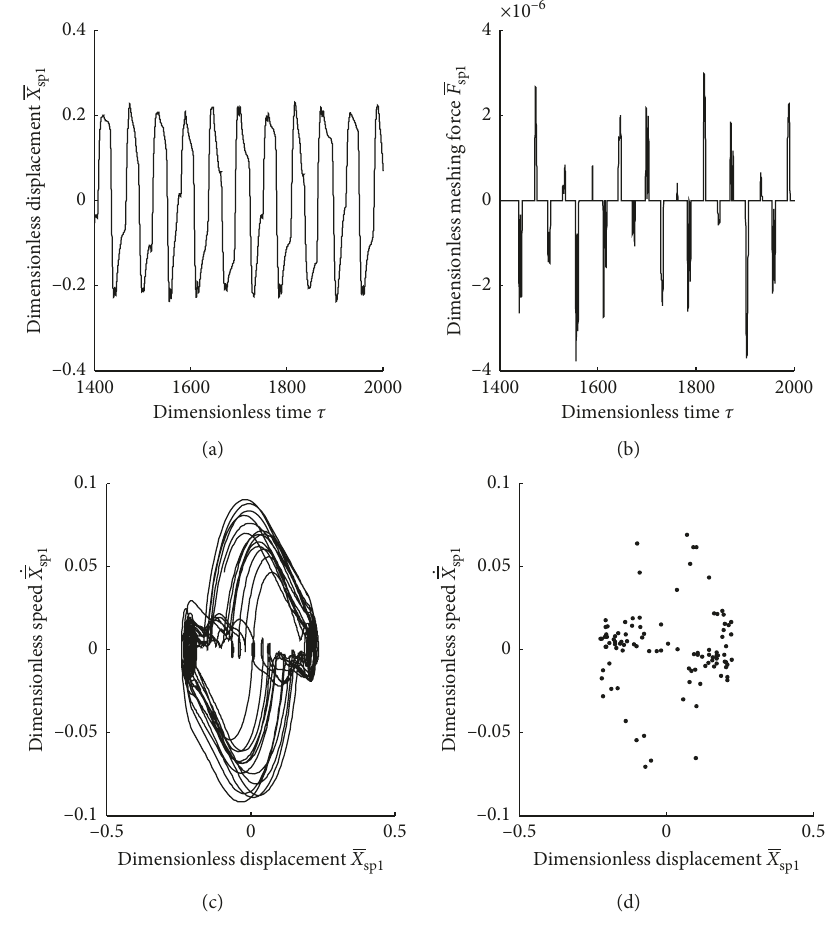
Figure 9: Process diagrams of response, phase diagram, and Poincar´e section under b process diagram of displacement response. (b) Time process diagram of meshing force response. (c) Phase diagram. (d) Poincar´e section.